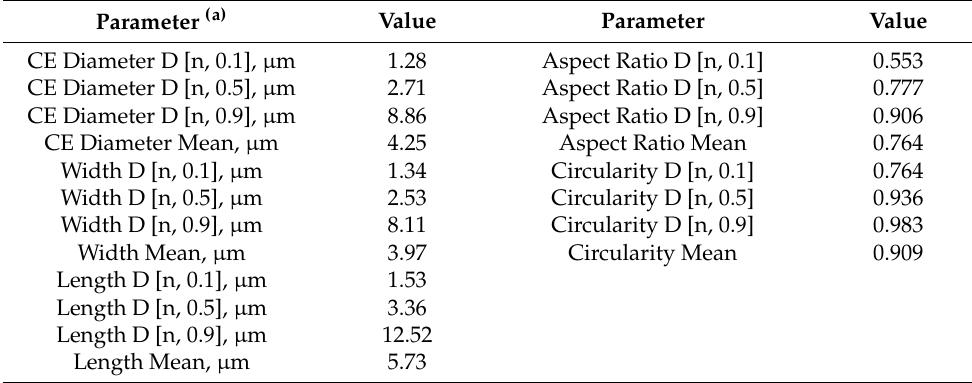
Table 3. Number particle size and shape distribution of the ash (sample PMA).